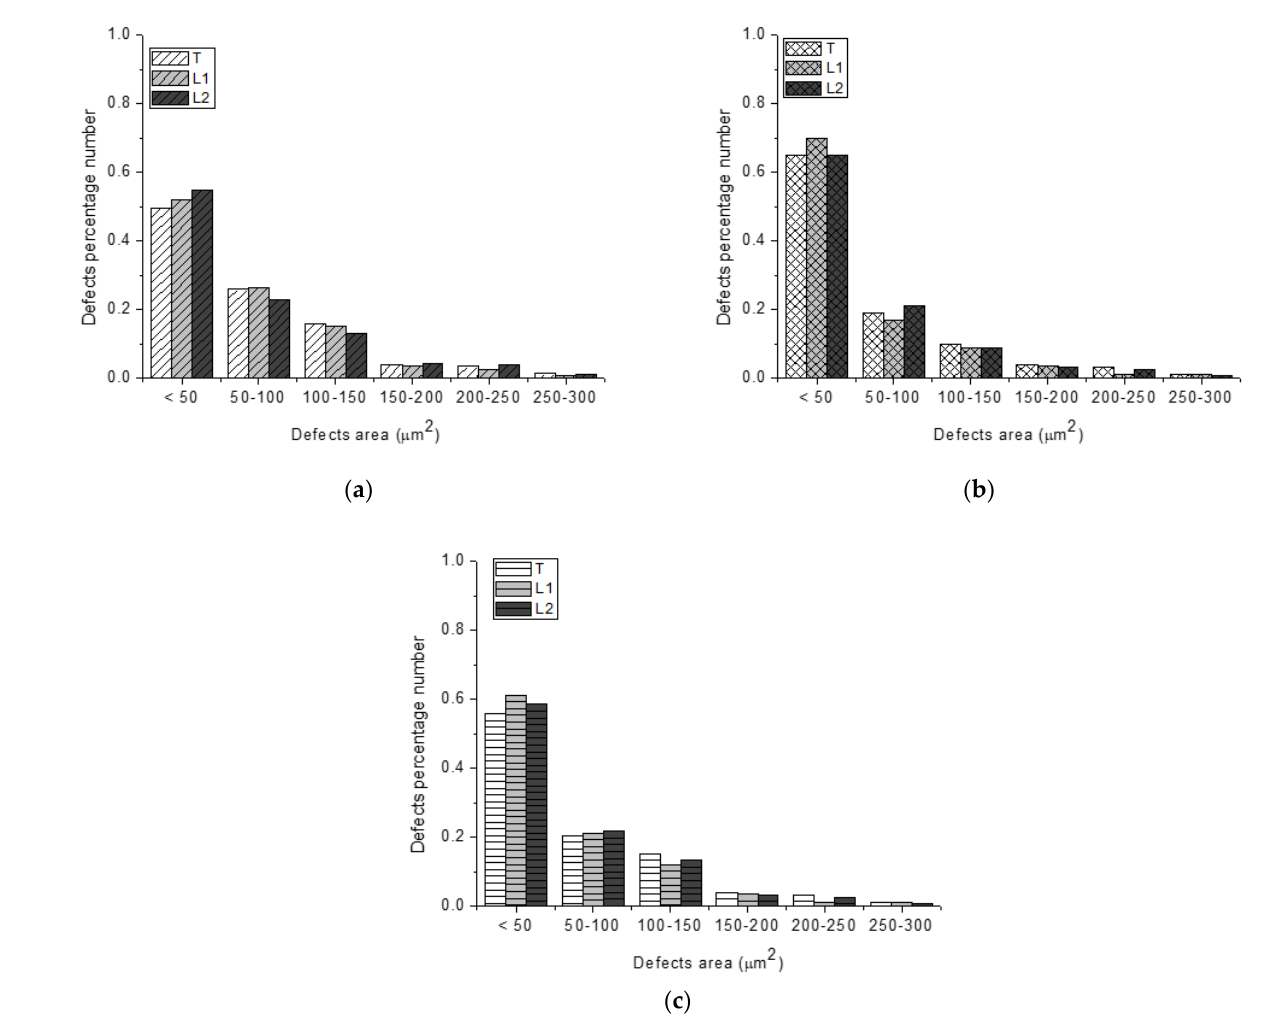
Figure 8. Distribution of defect numbers based on defect areas in the following specimens: ( a ) D 0 , ( b ) D d1 , and ( c ) D c1